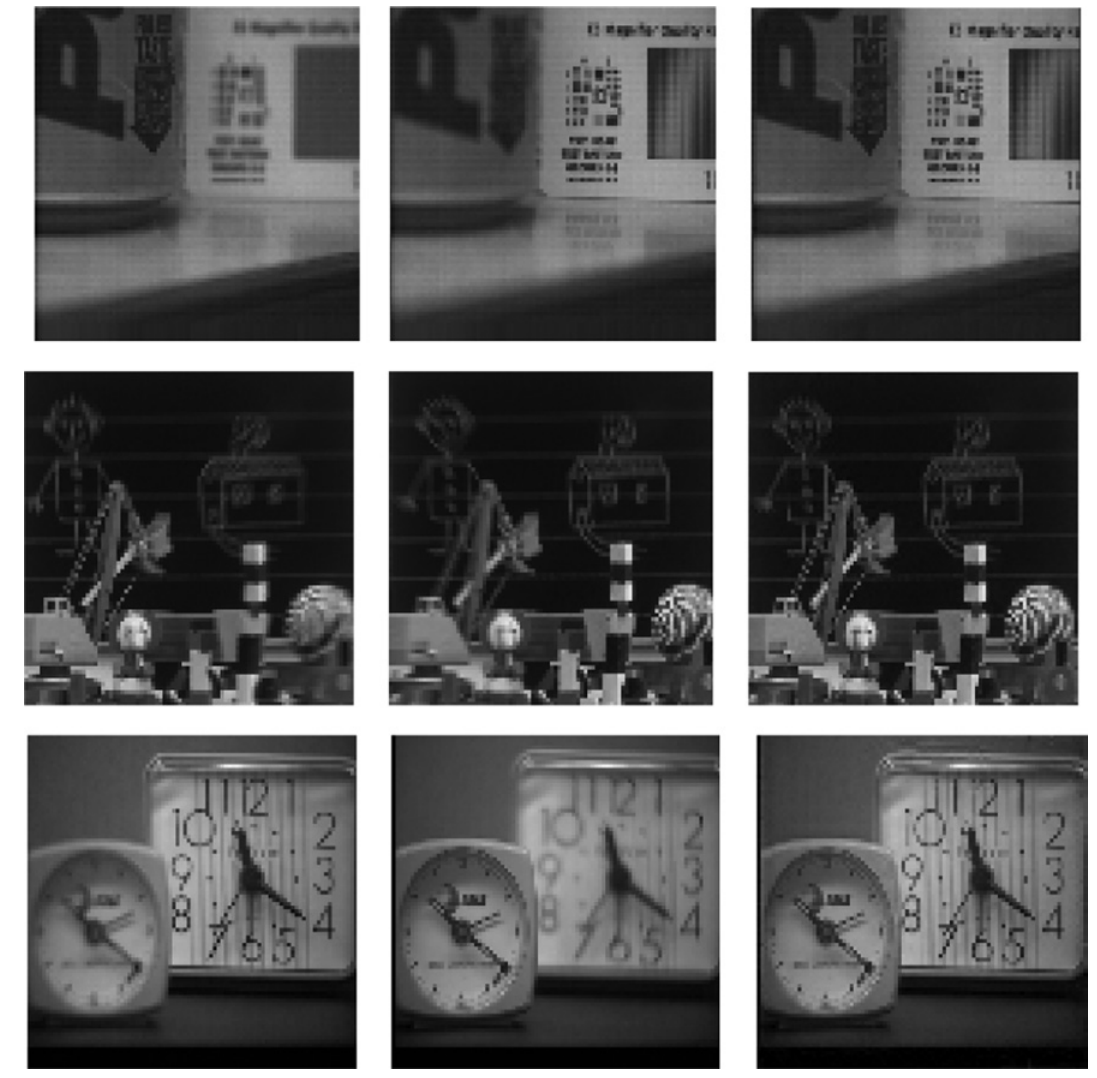
Figure 8: Fusion Results Based on NSCT Transform